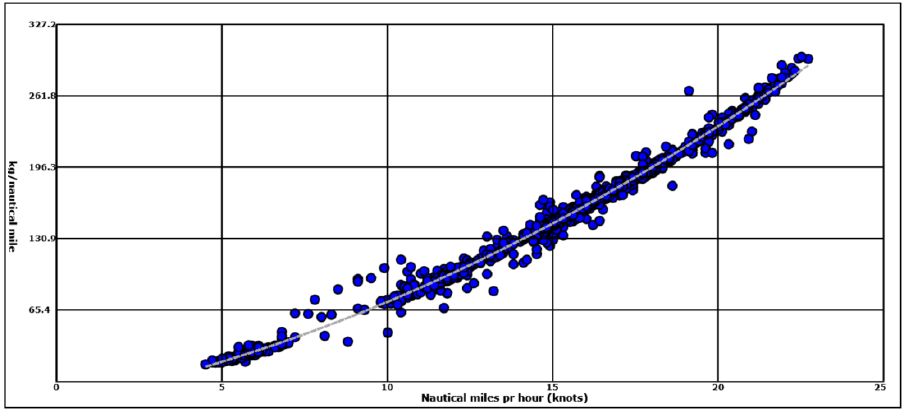
Figure 13. Load factor (actual power over installed power) profile for Norwegian Star , May 2016, using IMO formula. Blue points are estimated load factors for different speed values, gray line is fitted second-degree polynomial trend-line. Energies 2018 , 11 , x